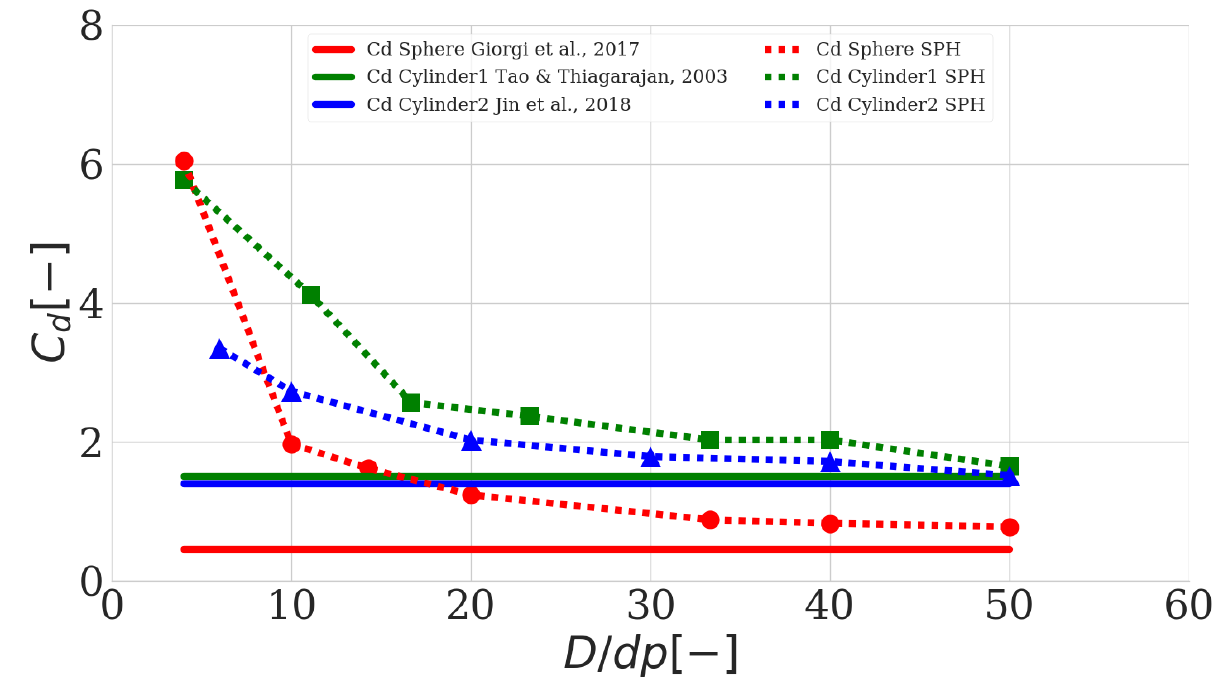
Figure 7. Convergence test for drag coefficient C d using a varying resolution for (i) a sphere with a = 1.5 m, T = 9 s [32], (ii) a cylinder with a = 0.045 m, T = 1.5 s (cylinder1, [56]) and a cylinder with a = 0.1 m, T = 1.2 s (cylinder2, [34]).